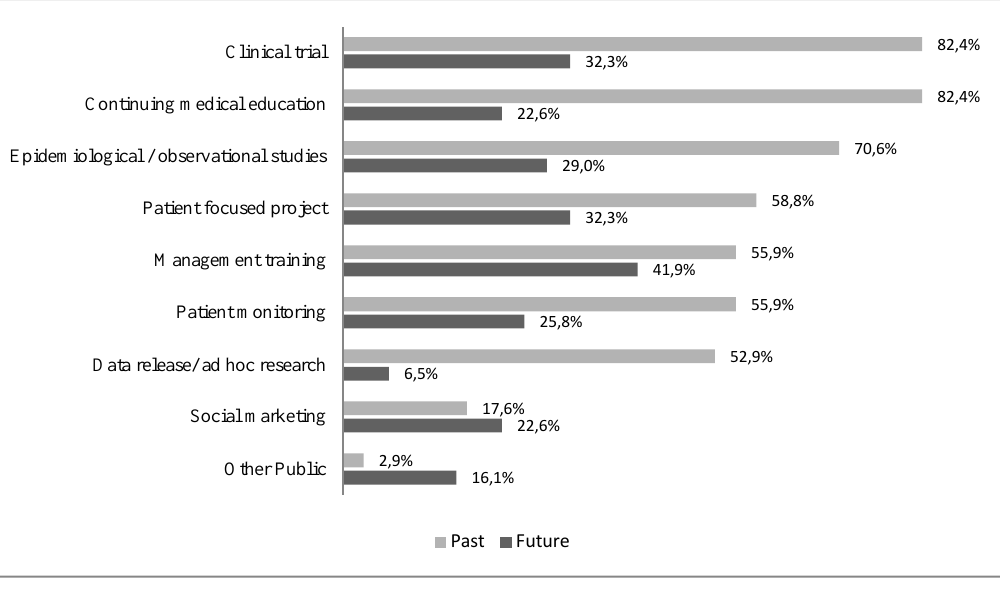
Source: Research Centre B-ASC. Based on research data. Figure 2: Percentage of Pharmaceutical Companies Collaborating in Outsourcing Complementary Activities per Period